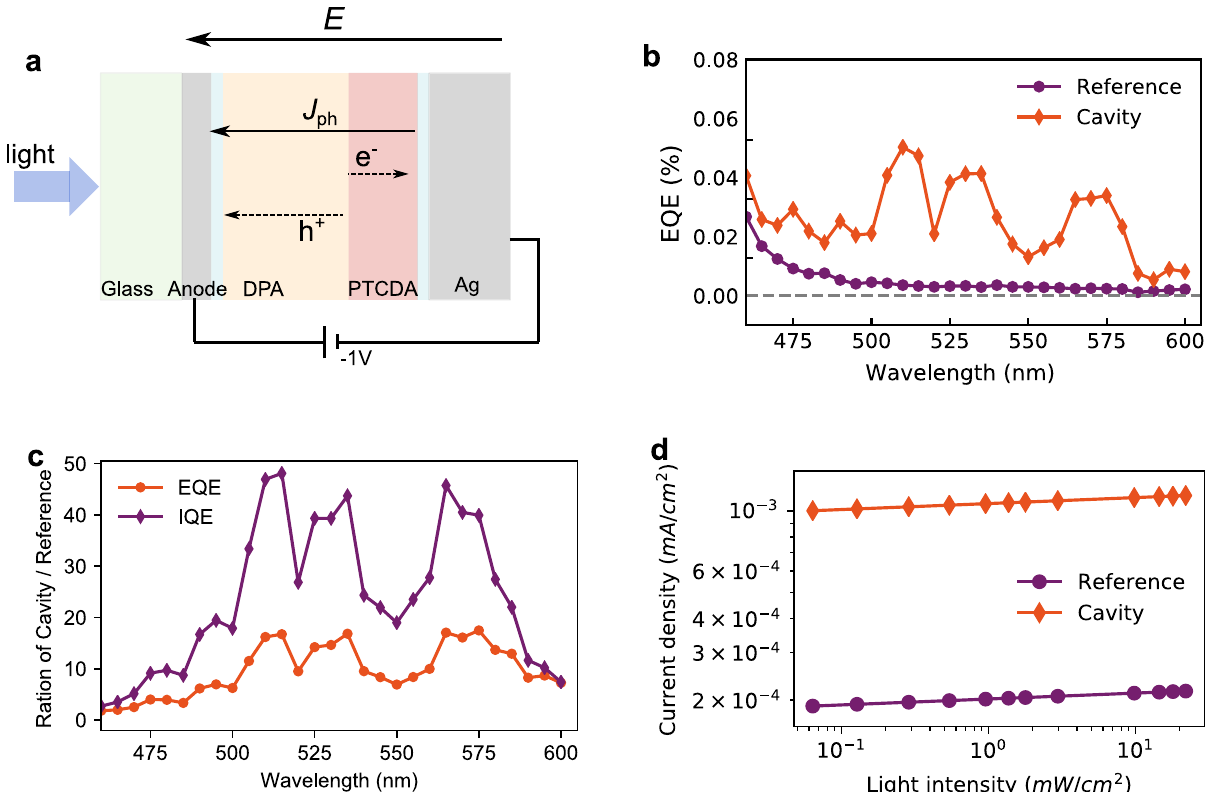
Fig. 4 Photoresponse of the cavity and reference devices. a The device structures. The anode for the cavity device is 20 nm Ag and 110 nm ITO for the reference device. Spacer layers of mCP and TmPyPB were 5 and 10 nm, respectively. b The EQE of the photodiode under − 1 V bias at short circuit condition. c The ratio of EQE and IQE of the cavity and reference devices. d The log – log plot of light intensity (475 nm) dependent photocurrent in cavity and reference